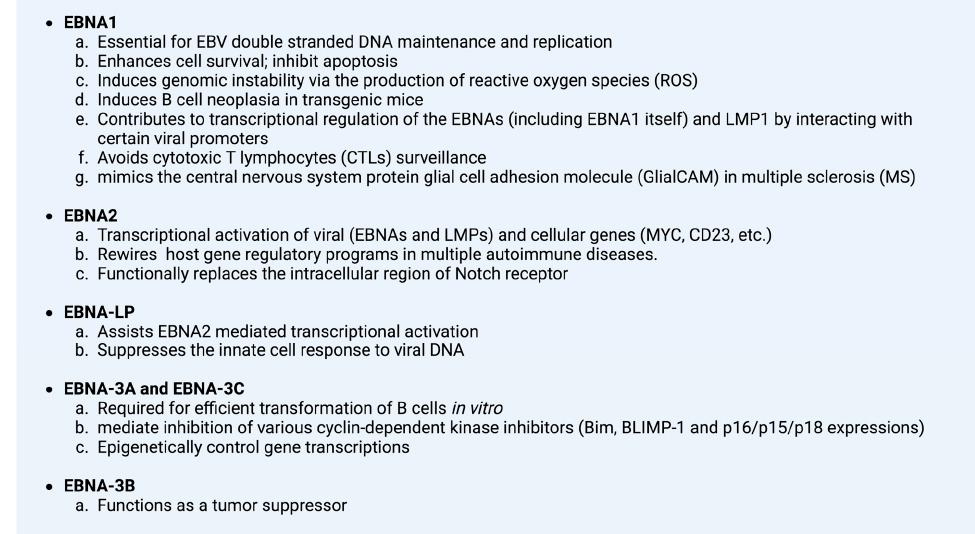
Figure 2. Summary of the functions associated with latent EBV nuclear